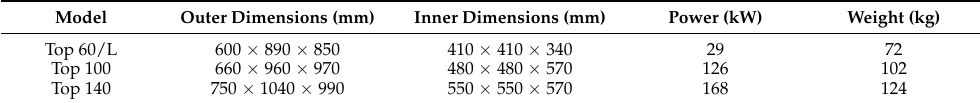
Table 3. The main characteristics of the range of furnace models of the European brand Nabertherm for sintering ceramics with maximum operating temperature T max = 1400 ◦